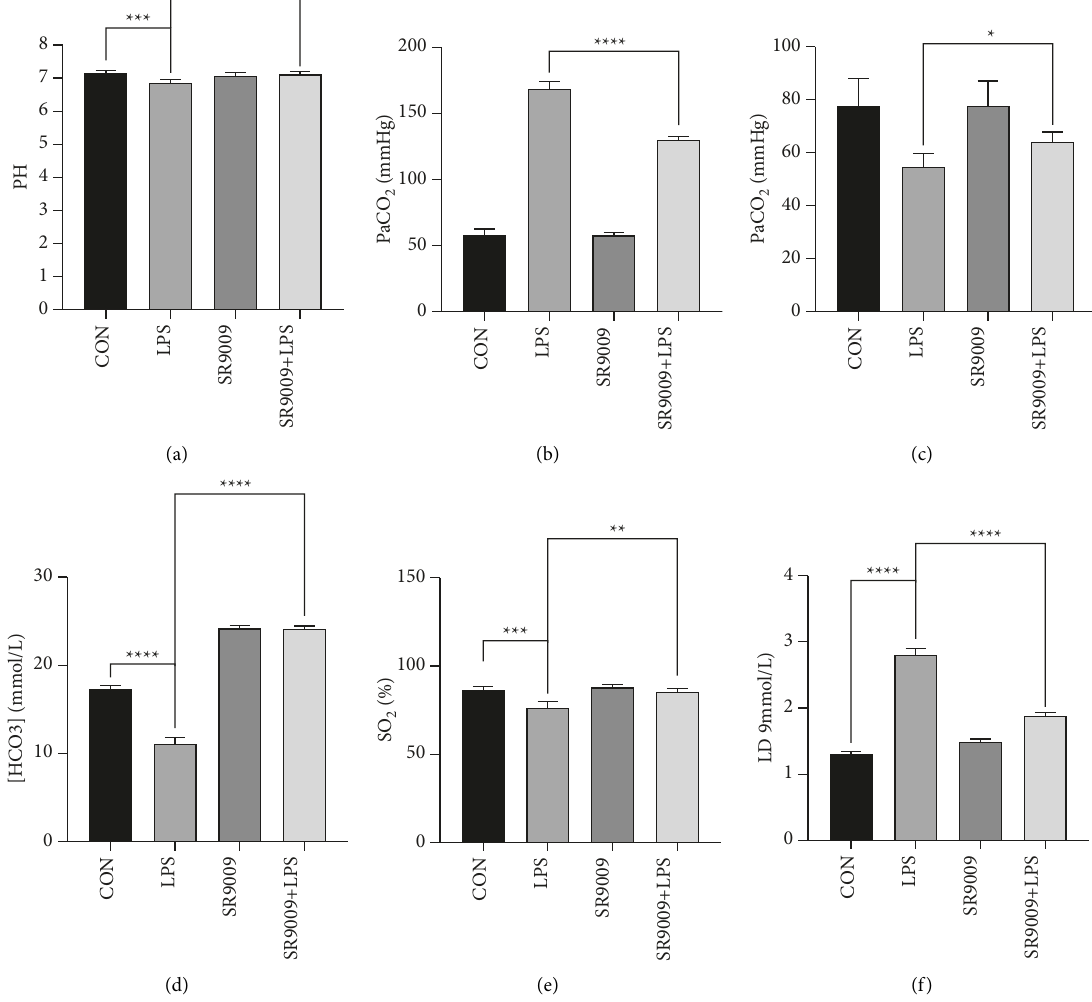
Figure 9: The effect of treatment on the arterial blood gas levels of different groups of mice ( n � 10): (a)–(f) are pH, PaCO HCO 3– concentration, SO 2 , and LD concentration, respectively. ∗ p < 0 . 05, ∗∗ p < 0 . 01, ∗∗∗ p < 0 . 001, and ∗∗∗∗ p < 0 .